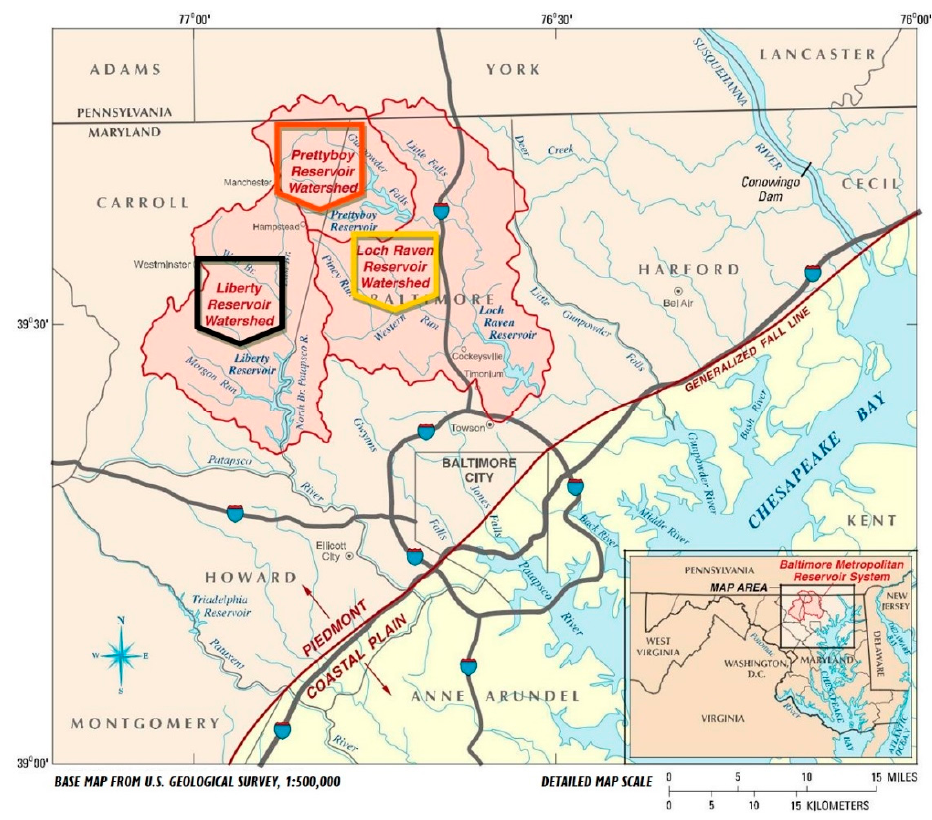
Figure 1. Map depicting watersheds and reservoirs supplying Baltimore City’s drinking water.